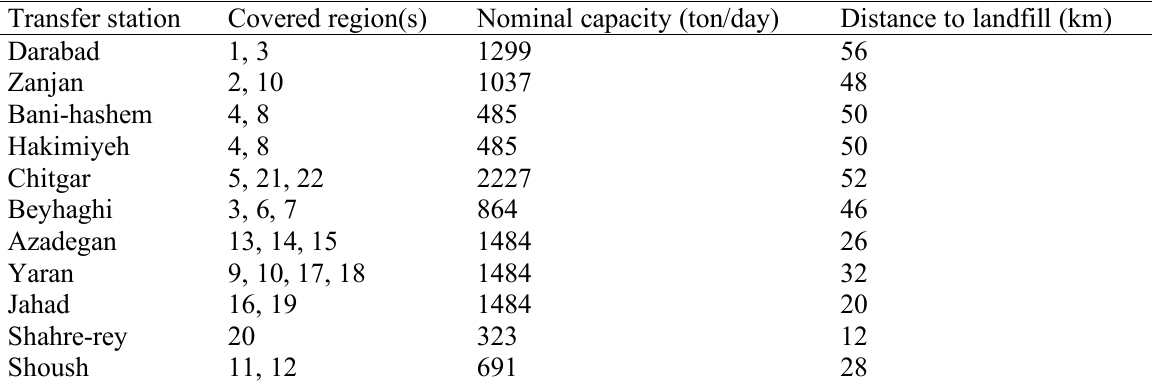
Table 4. Transfer stations characterization (Akbarpour Shirazi et al., 2016) Transfer station